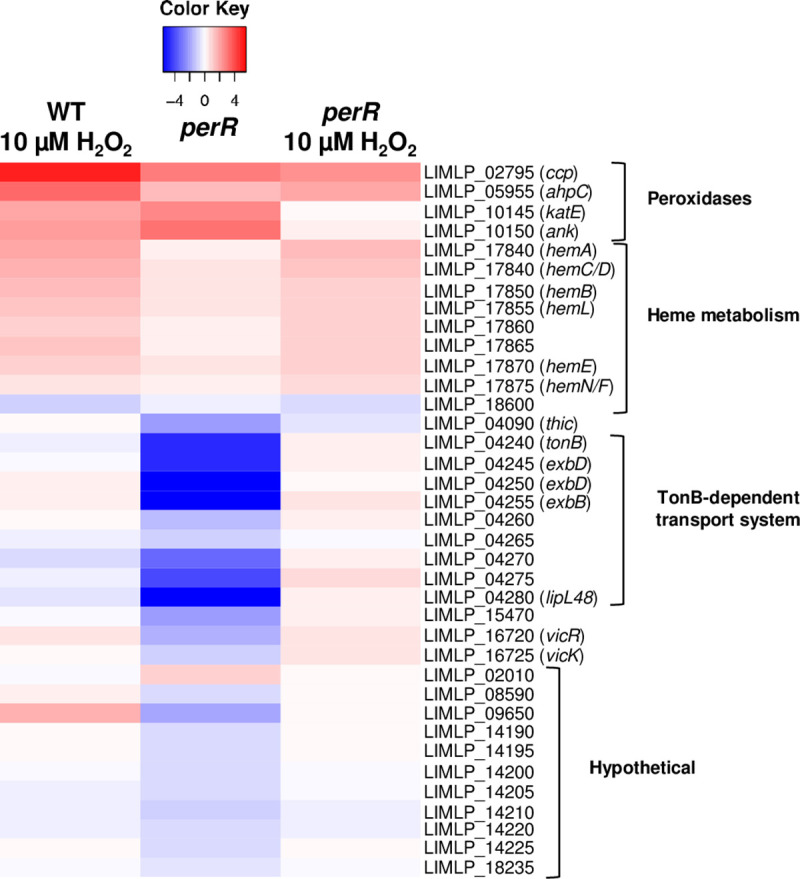
Comparison of differentially-expressed genes upon exposure to hydrogen peroxide and perR inactivation.The expression of selected differentially-expressed genes determined by RNA-Seq when WT L. interrogans are exposed 30 min to 10 μM H2O2 was compared to that in the perR (M776) mutant in the absence or presence of 10 μM H2O2. Gene expression in the perR mutant strain with H2O2 was normalized here with that of the perR mutant strain without H2O2. Genes are organized by their function and their number and name are indicated on the right. The Heat Map color from blue to red indicates low to high Log2FC.